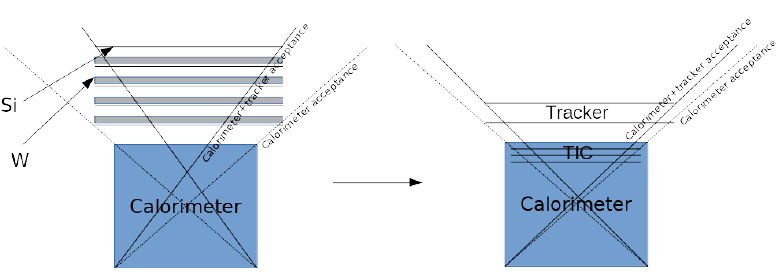
Figure 3. Schematic picture of the standard configuration of a tracker-converter (left) and the TIC basic idea (right). For simplicity only the top face of the instrument is considered in this